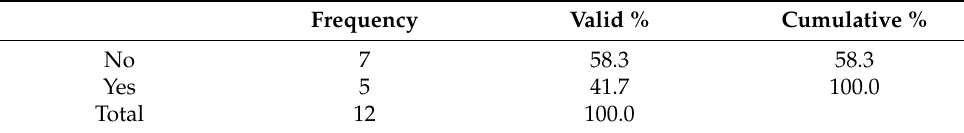
Table 5. Weekly hours of direct support by the mentor to co-workers.